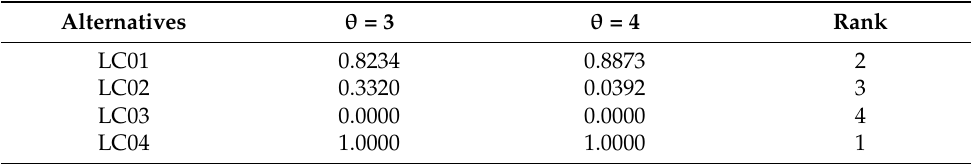
Table 6. Sensitivity